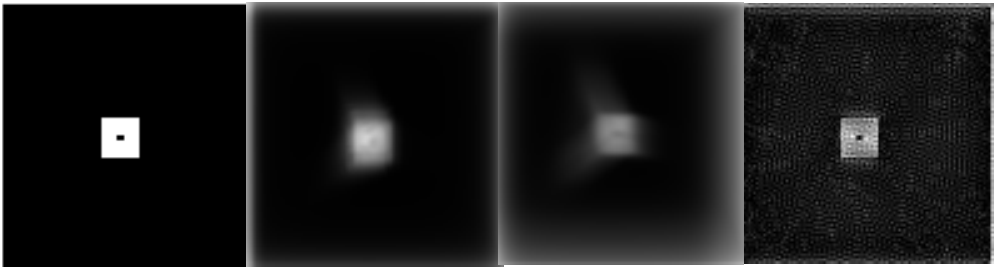
Figure 5. Simulation result of the PDS correction method.